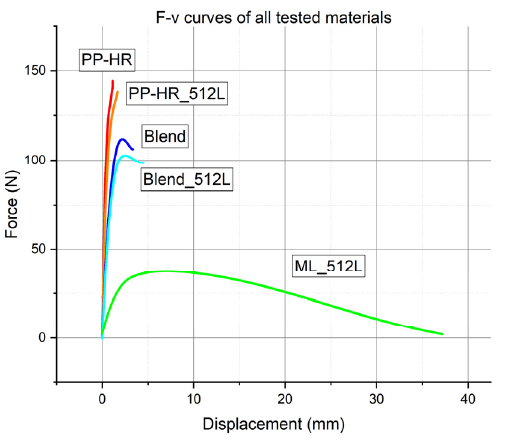
Figure 3. Representative force–displacement curves in instrumented Charpy experiments for un- notched materials.